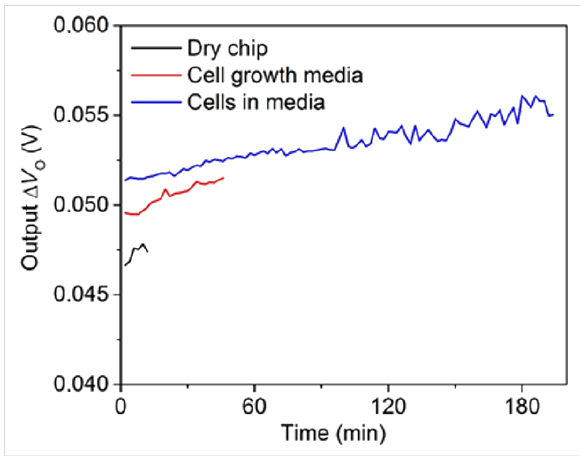
Figure 6: Average voltage change from the baseline over time from all sensors on one chip after cell media and cells were added. The aver- age signal from the sensors on the dry chip is added for